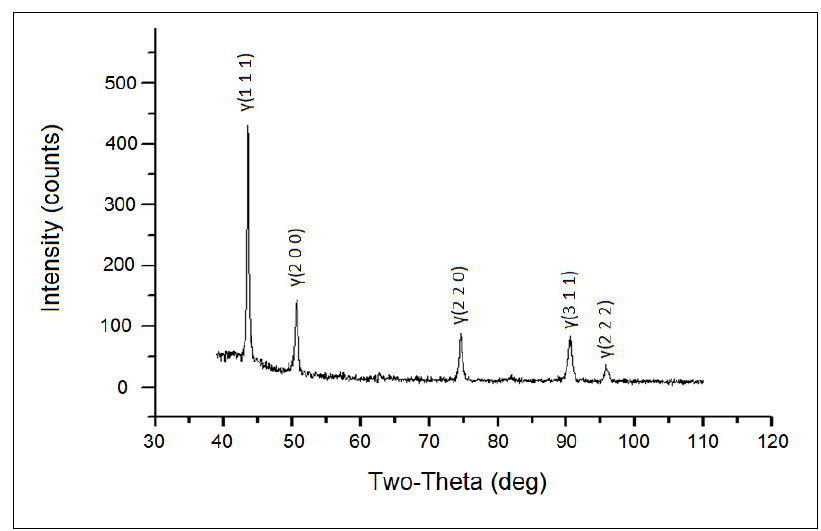
Fig. 3. XRD patterns from powder AISI 316L.